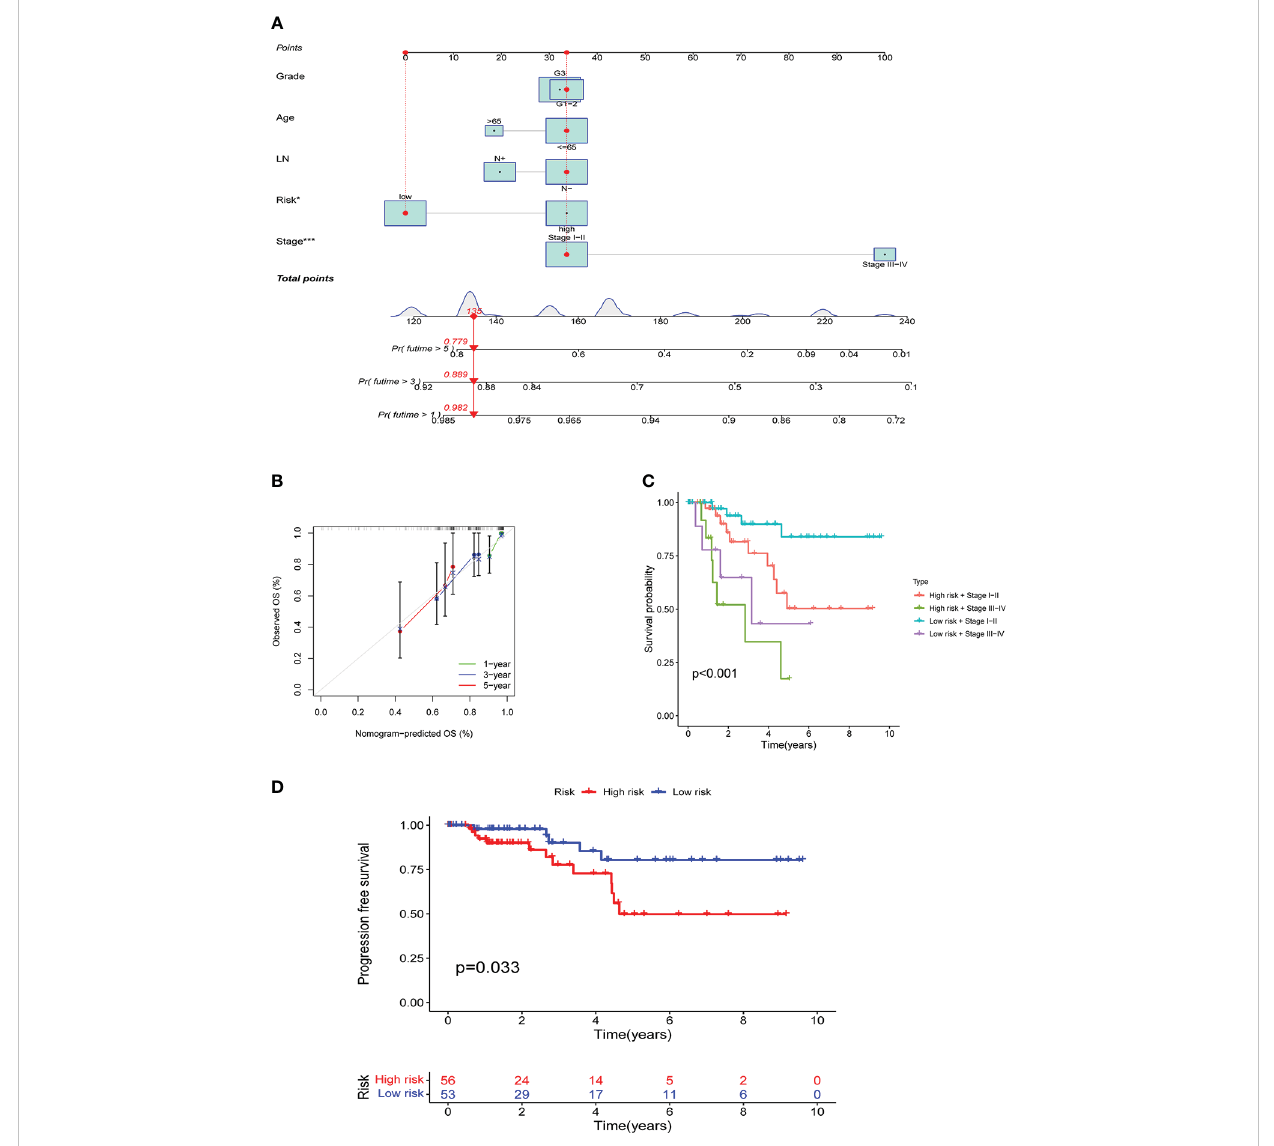
FIGURE 7 Results of the risk score assessment on the prediction of prognosis of patients: A shows the nomogram based on age, lymph node metastasis, pathological grade, risk score, and clinical stage, B shows the results of prediction accuracy validation in the model, C shows the results of further prognostic analysis, D shows the results of PFS